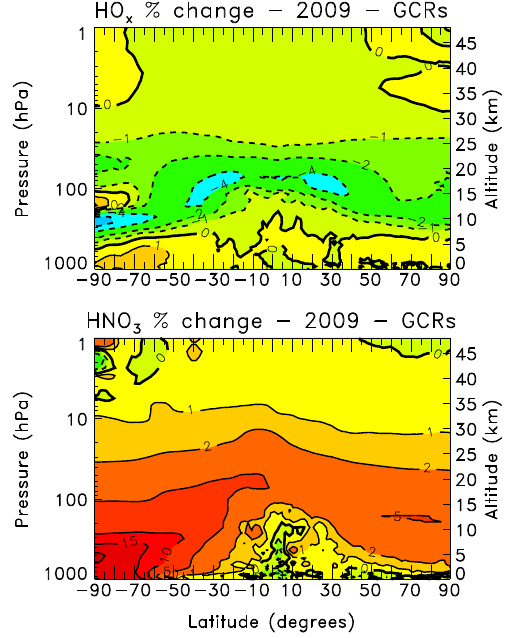
Figure 7. Annual average percentage change from year 2002 (so- lar maximum) to 2009 (solar minimum) in zonal mean NO x (top) and ozone (bottom) in the SD-WACCM. Simulations GCR_SD-W and Base_SD-W were used for this comparison. The annual average percentage change from GCRs was computed for years 2002 and 2009 separately and then differenced from each other. The contour intervals for the NO x changes are 0, 1, 2, 4, 6, 8, and 10%. The contour intervals for the ozone changes are − 1, − 0 . 5, − 0 . 2, − 0 . 1, 0, 0.1, 0.2, 0.5, and